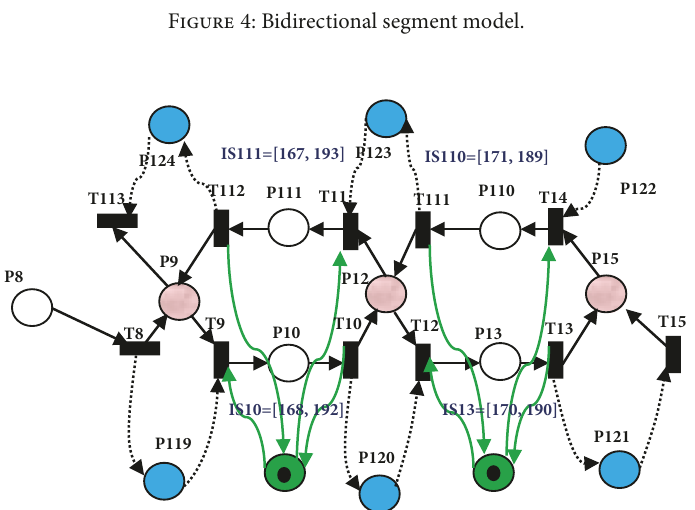
Figure 5: Places representing the direction of trains